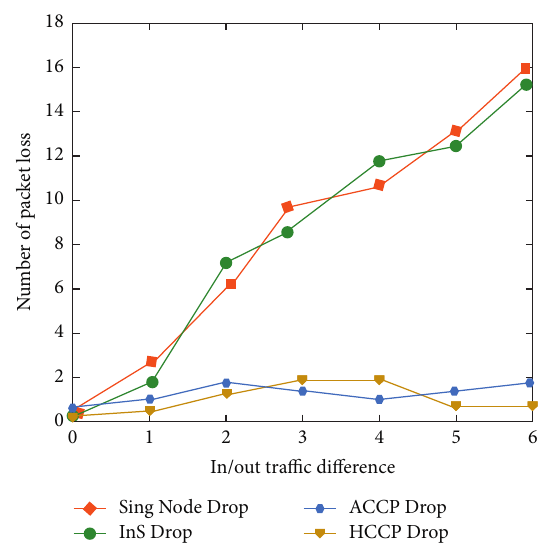
Figure 4: Changes in the transmission